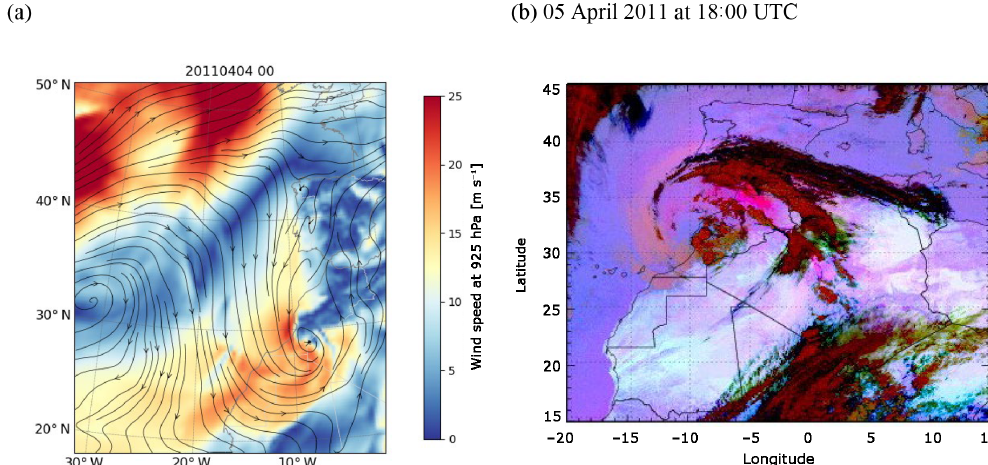
Figure 2. (a) ECMWF ERA5 reanalyses of wind speed at 925hPa (colors) and wind direction at 700hPa (streamlines) on 4 April 2011 at 00:00UTC. (b) SEVIRI-derived false color images over North Africa, showing dust (pink), clouds (brown/red) and differences in surface emissivity retrieved in absence of dust or clouds (light blue/blue) on 5 April 2011 at